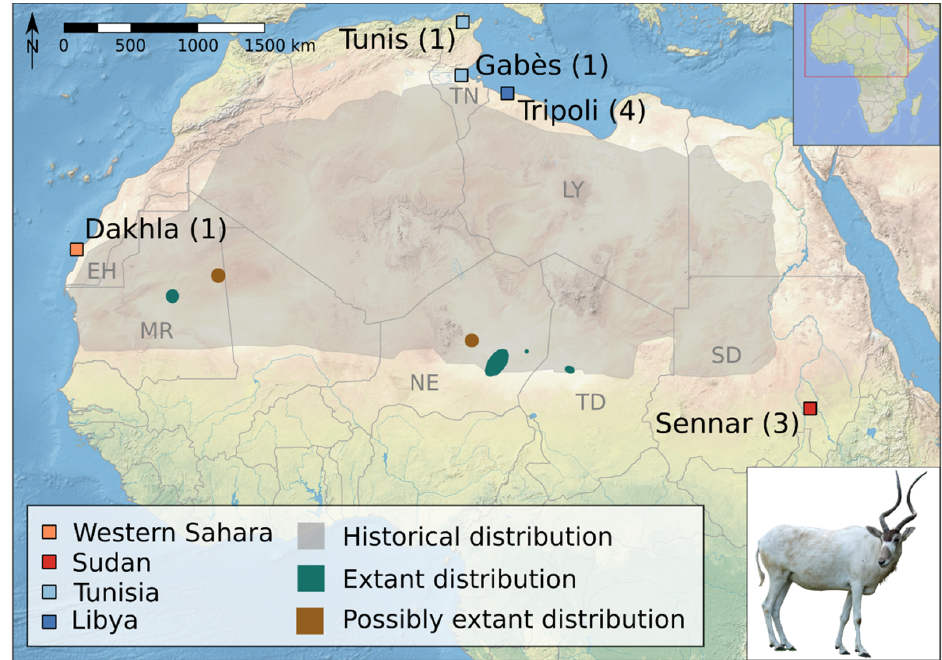
Figure 1. Map of sample locations . Historical and (possible) extant distribution of the addax [1,6] and location of historical samples with sample sizes in parenthesis (photo credit: E. Hempel; base map: https://www.naturalearthdata.com, accessed on 18 October 2017, generated in QGIS v2.18 https://www.qgis.org). EH: Western Sahara, LY: Libya, MR: Mauritania, NE: Niger, SD: Sudan, TD: Chad, TN: Tunisia.